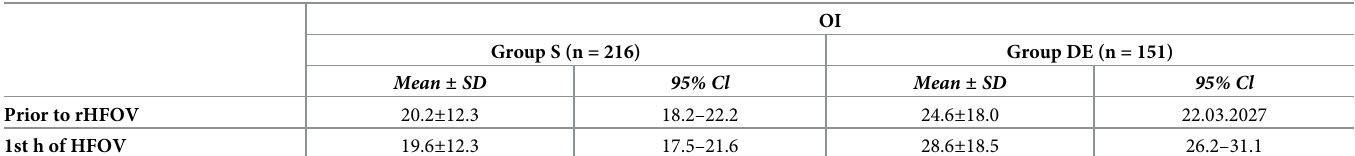
Table 4. Evolution of OI with HFOV treatment.